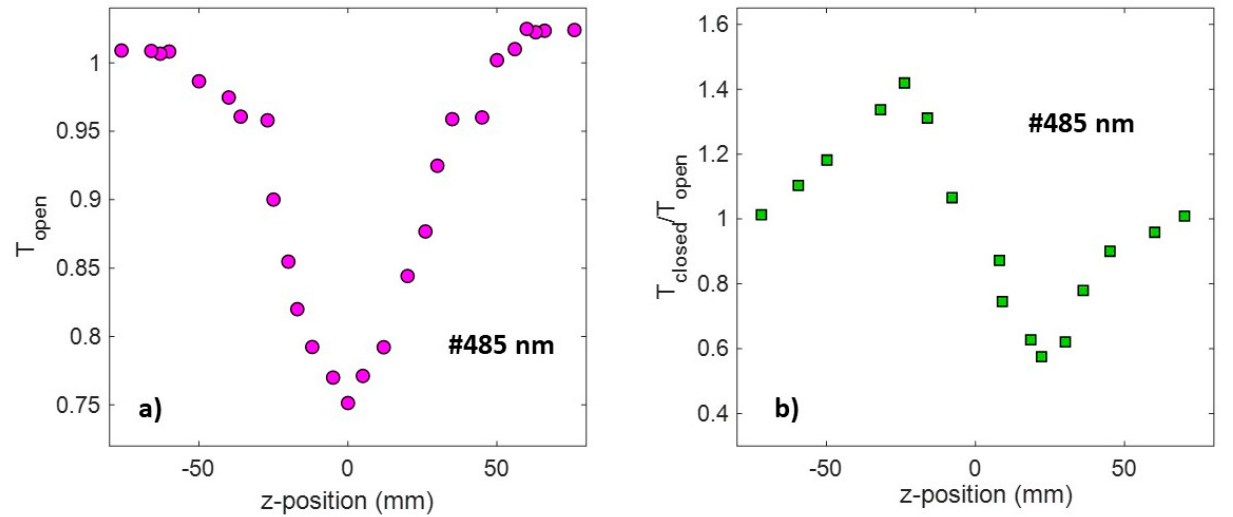
Figure 4. Z-scan profile in open (a) and closed/open (b) configurations for the sample #485 nm.